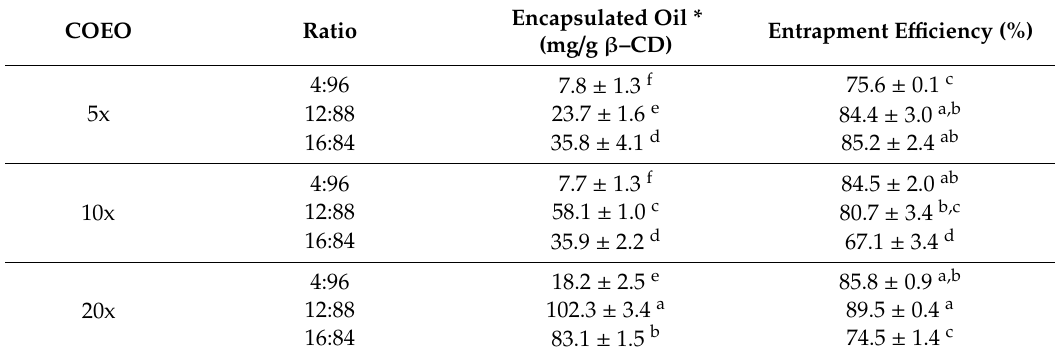
Table 2. Entrapment e ffi ciency (%) and encapsulated oil values (mg / g β –CD) for each COEO: β –CD ratio. COEO Ratio